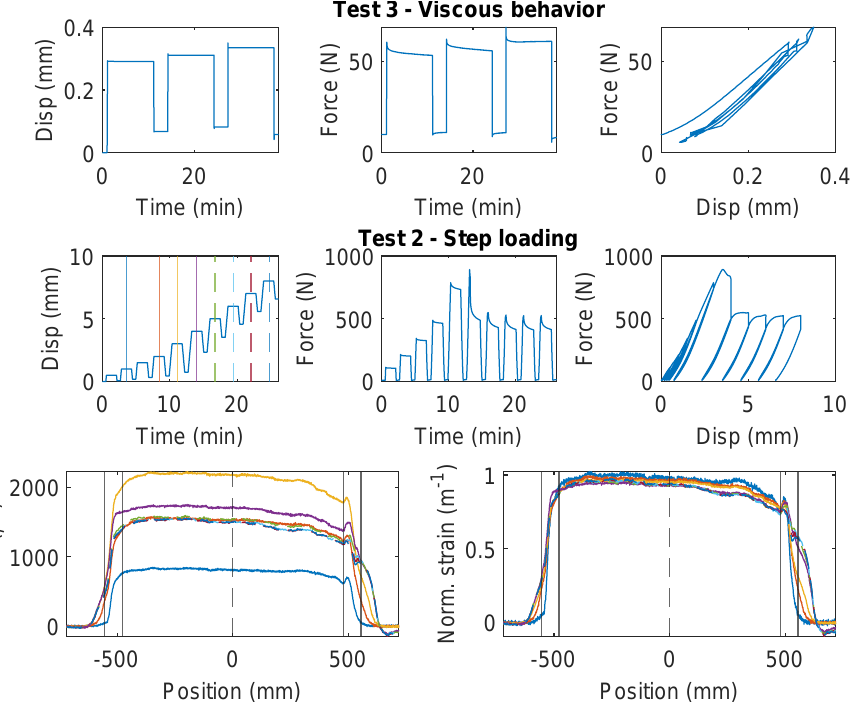
Figure 14. The loading protocol, force–displacement relation and strain distributions under increasing displacement levels (represented by different color lines) for Specimen 3 of the Stranded Steel 5.0 mm cable.